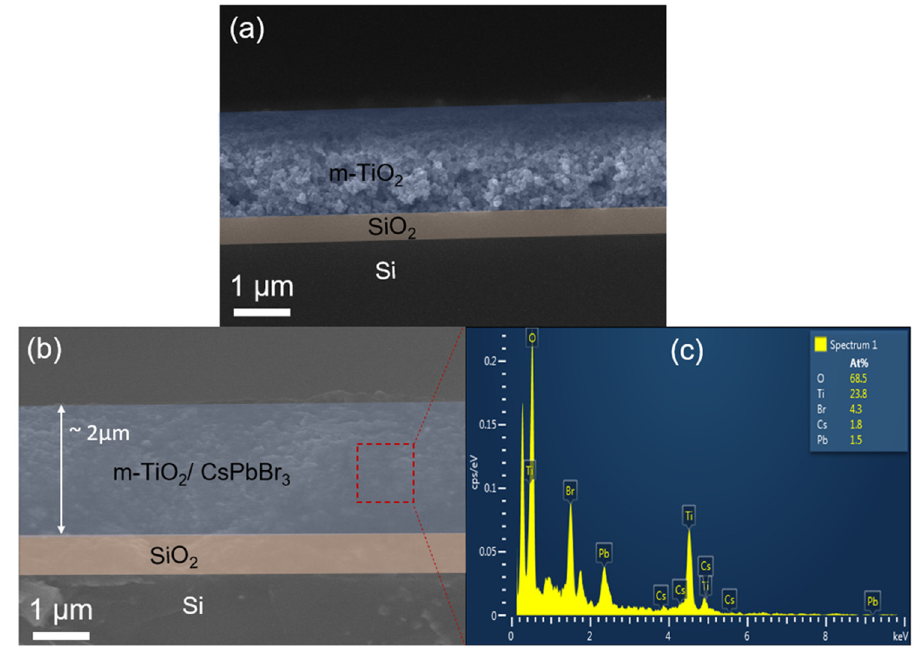
Figure A2: ( a and b ) The SEM cross - section images of mp - TiO 2 before and after perovskite QD in fi ltration. ( c ) EDS spectrum of CsPb 1 – x Mn x Br 3 – 2 x Cl 2 x ( x = 0.5 )- coated m - TiO 2